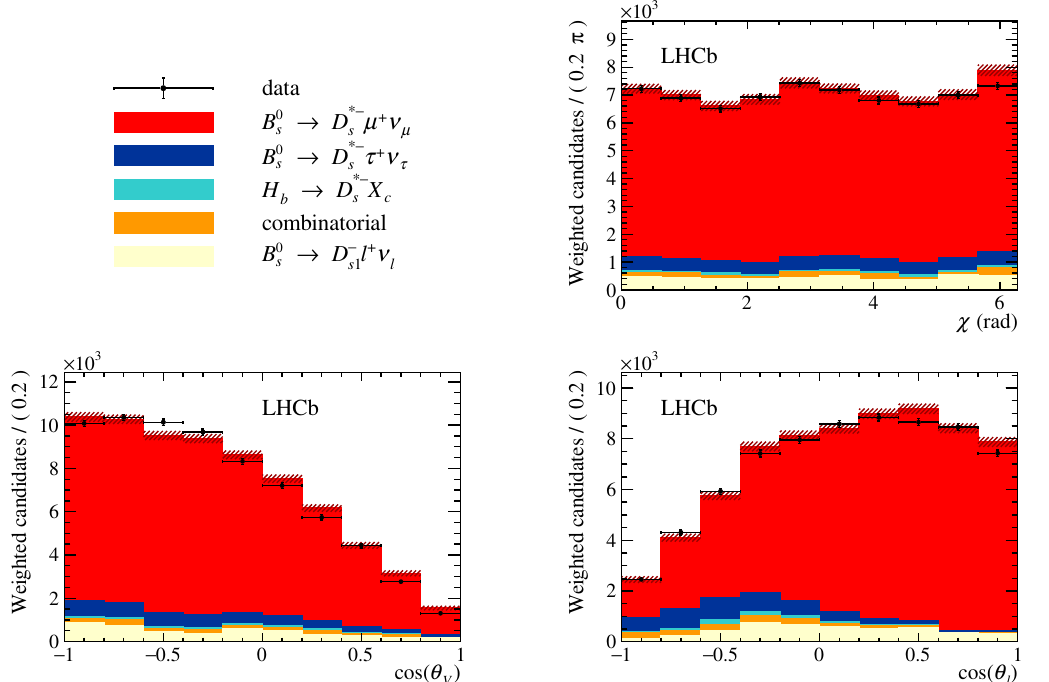
Figure 4 . Distribution of (top right) χ , (bottom left) cos( θ D ) and (bottom right) cos( θ µ ) s integrating over w and the other decay angles from data (black points) compared to the dis- tribution from simulation with their relative size extracted from the fit to the corrected mass. The B 0 → D s 1 (2460) − τ + ν τ and the B 0 → D s 1 (2460) − µ + ν µ components are combined in s s B 0 → D s 1 (2460) − ‘ + ν ‘ . The uncertainties on the templates, indicated by the hashed areas in the s figures, are a combination from all